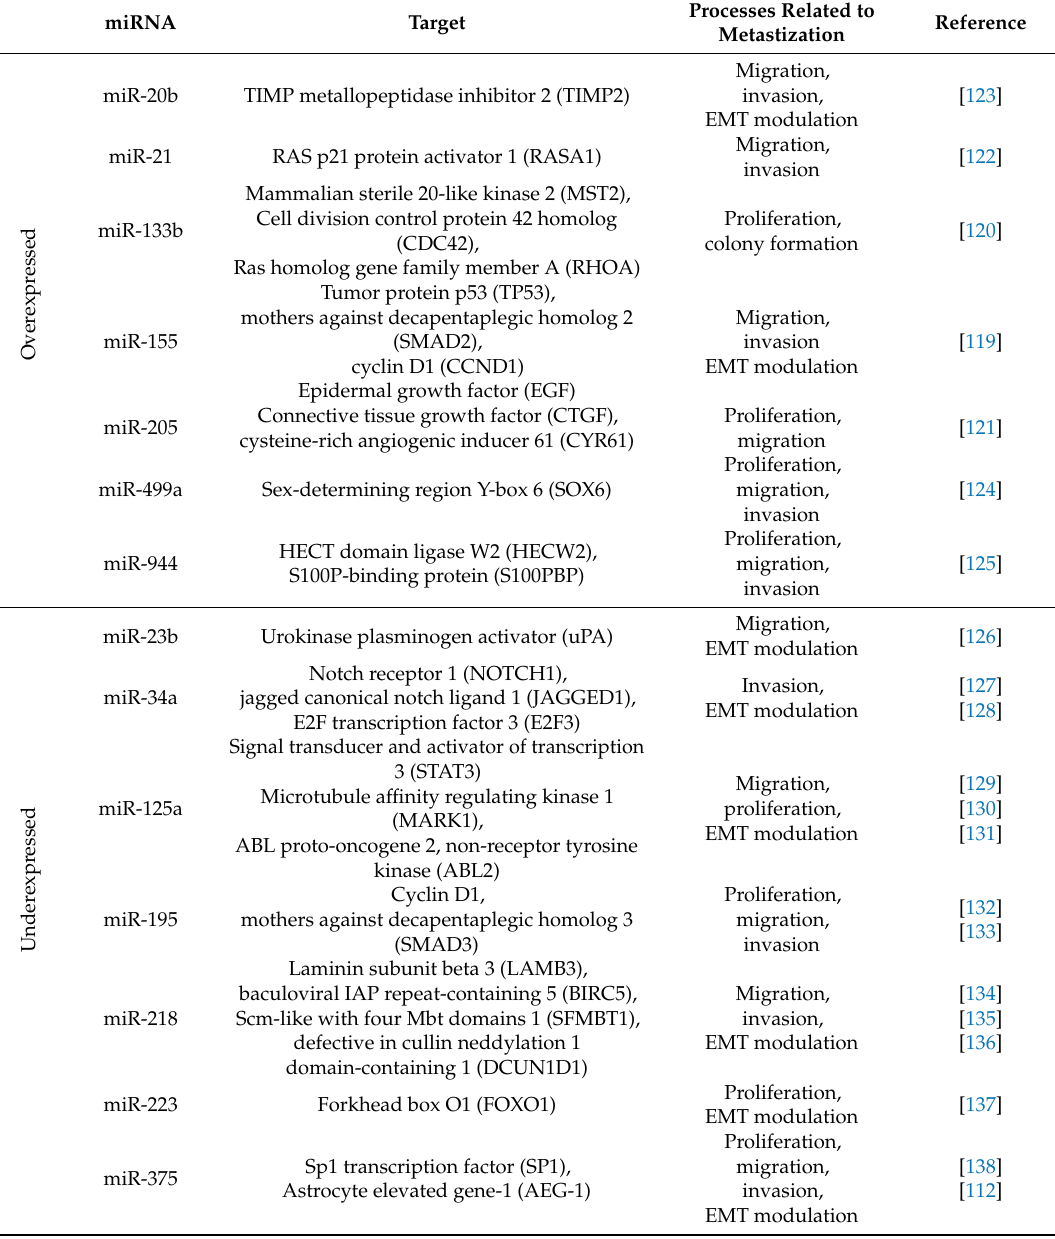
Table 2. Impact of metastamiRs contributing to cervical